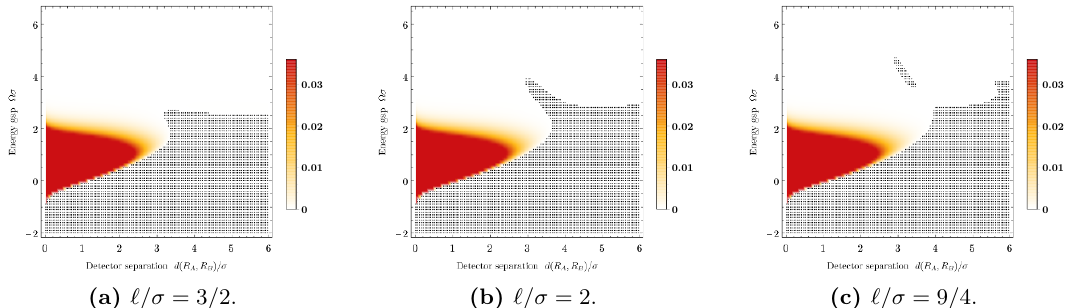
Figure 9 . The concurrence is plotted as a function of a pair of detectors’ proper separation d ( R A ; R B ) =(cid:27) and energy gap (cid:10) (cid:27) for transparent boundary conditions (cid:16) = 0 satis(cid:12)ed by the (cid:12)eld. As the AdS length ‘=(cid:27) increases, moving from plot (a) to (c), an island of separability emerges. In all plots, detector A is located at the origin. The area (cid:12)lled with black dots represents the region where the concurrence vanishes and thus no entanglement harvesting is